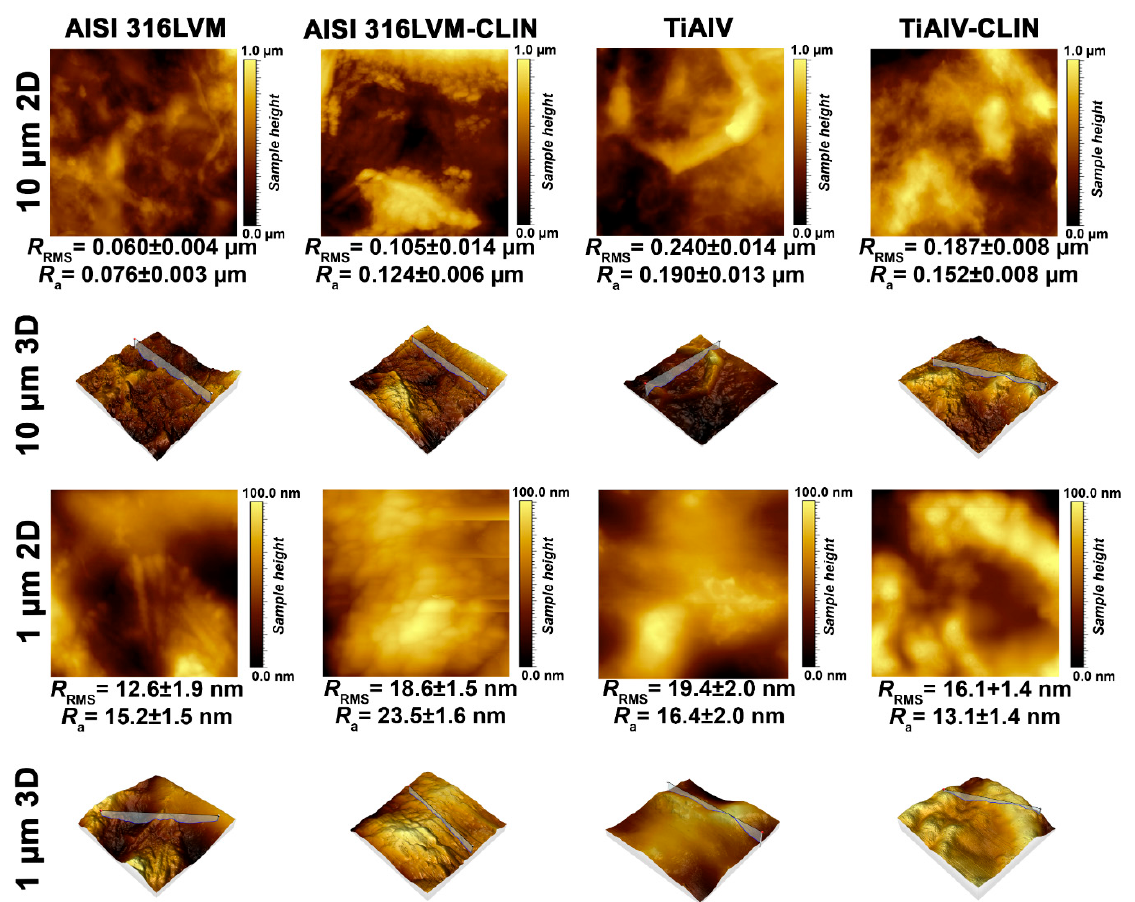
Figure 4. Surface morphology and roughness parameters of the 3D-printed coatings as measured by atomic force micros- copy (AFM).